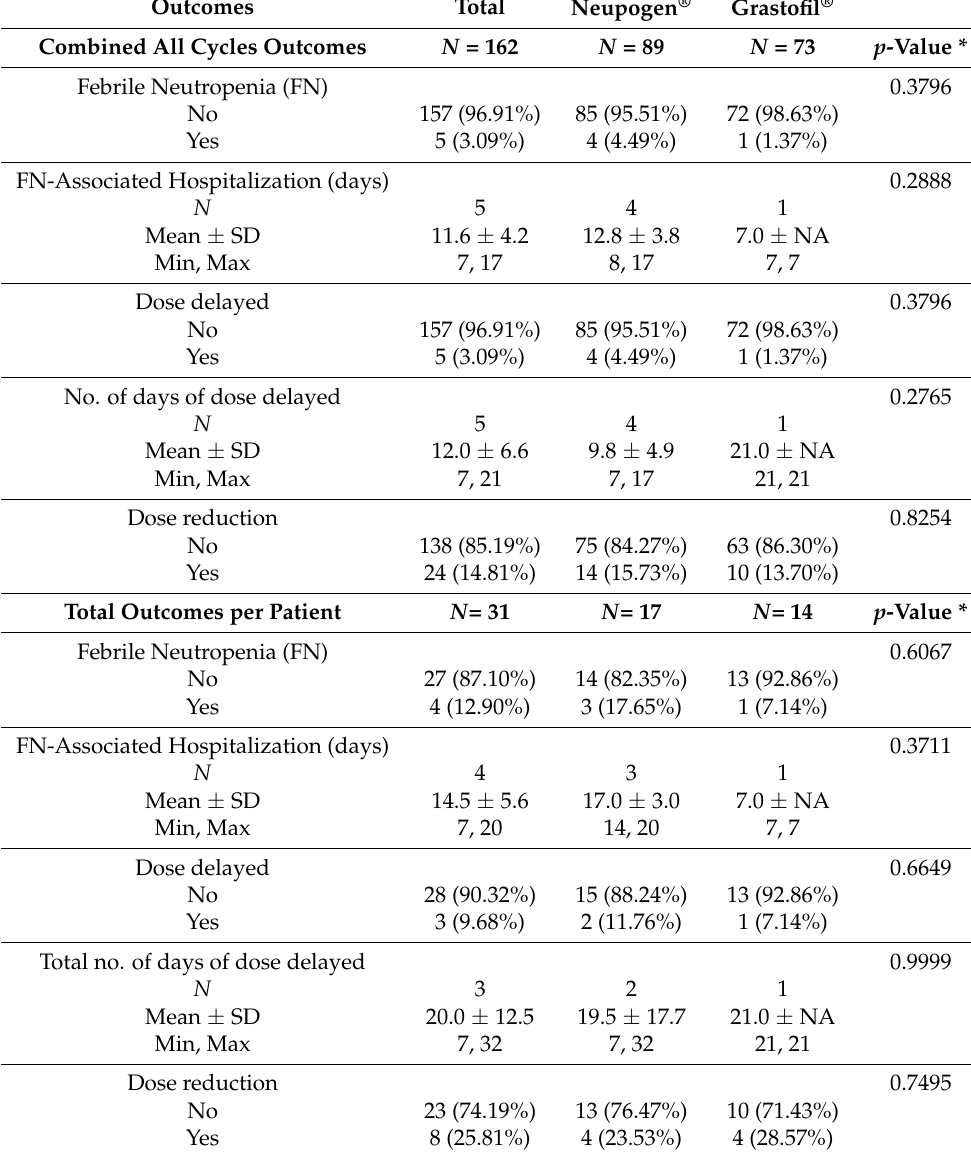
Table 7. Combined Lymphoma